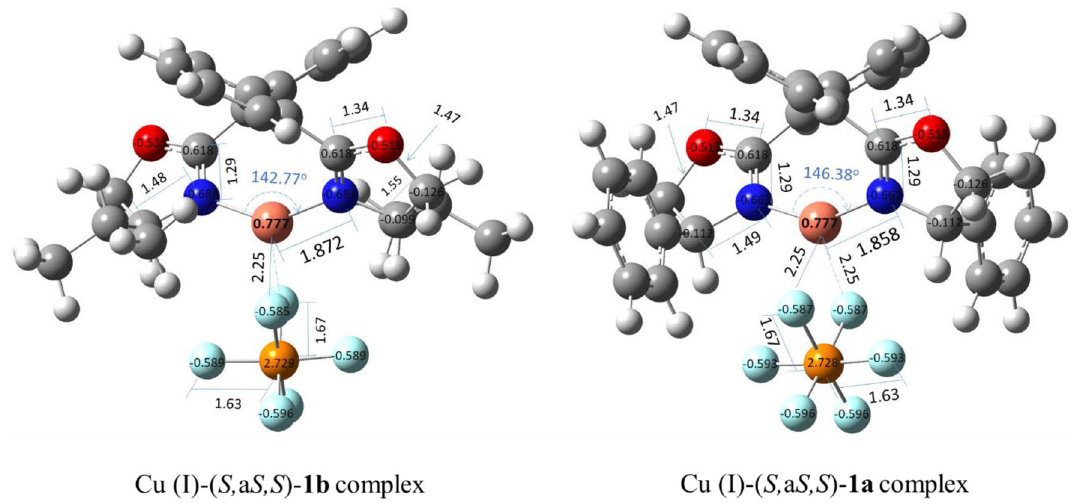
Figure 4. Bond lengths and partial charges on selected atoms in the Cu (I)-( S ,a S , S )- 1a and - 1b complexes